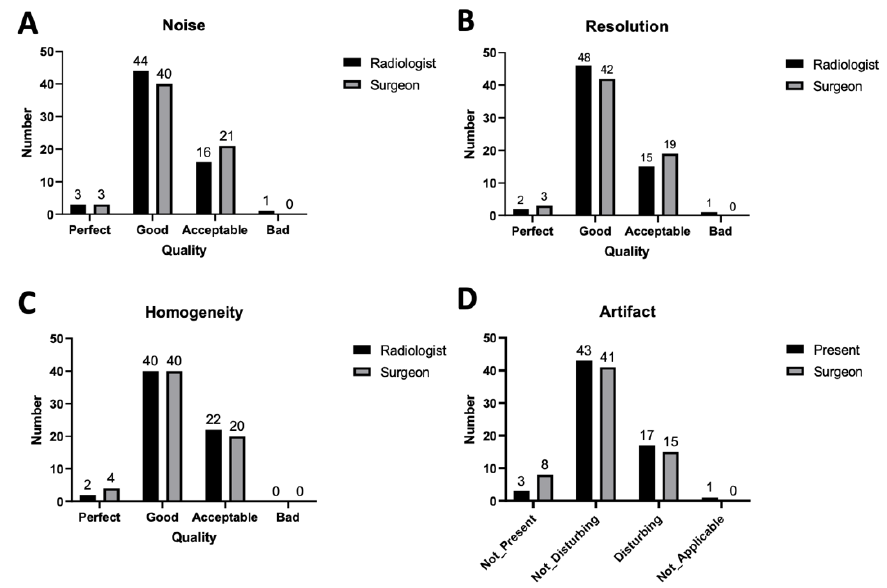
Figure 1. Imagequalitycomparison, including( A )noise, ( B )resolution, ( C )homogeneity, and( D Figure 1. Image quality comparison, including (A) noise, (B) resolution, (C) homogeneity, and (D) artefacts.